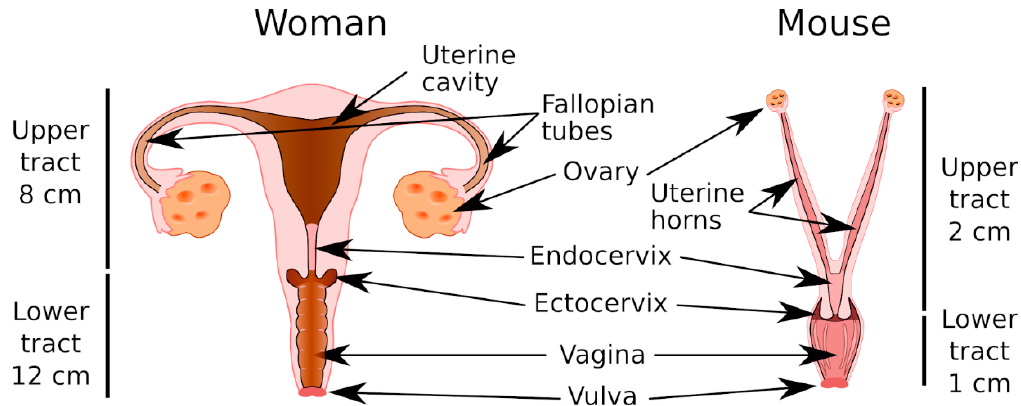
Figure 1. Women have a large pear-shaped uterine cavity. The transition between the uterus and vagina occurs in the cervical canal between the mucus-secreting endocervical epithelium and the stratified squamous epithelium of the ectocervix. The vagina is lined by a squamous and muscular epithelium that is not keratinized. The mouse uterus is bicornuate. As for the woman, the lower genital tract in the mouse contains the cervix, which includes the endocervix and the ectocervix, and opens into the vaginal cavity. The mouse vaginal epithelium is keratinized.